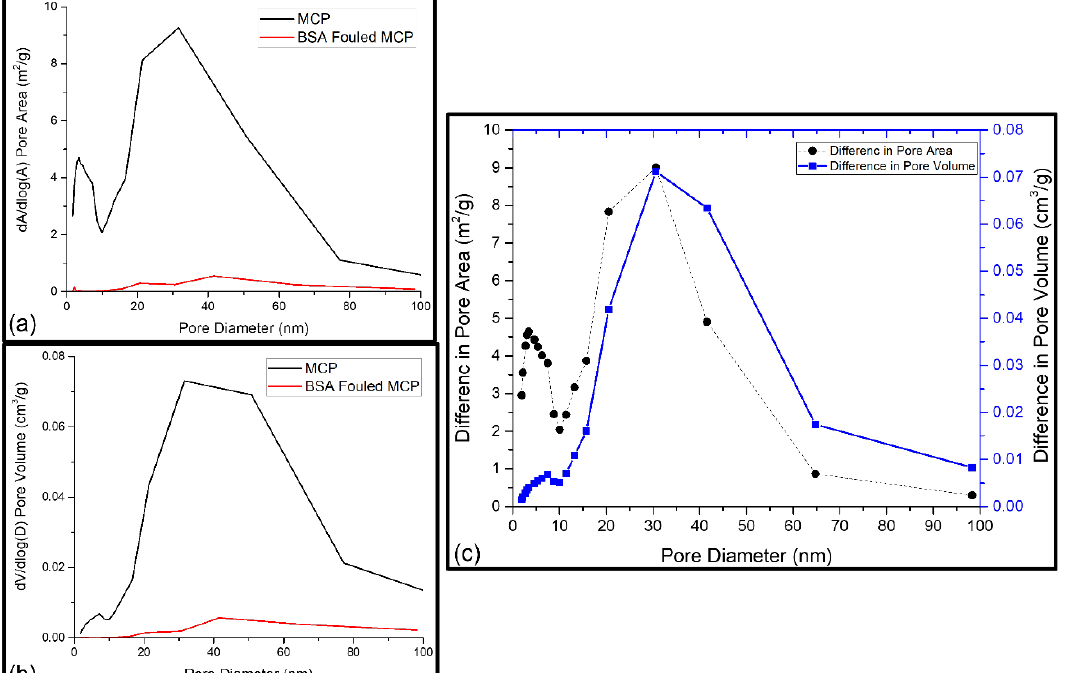
Figure 6. ( a ) BET pore area distribution of CP and BSA-fouled CP membranes; ( b ) BET pore volume distribution of CP and BSA-fouled CP membranes; ( c ) the difference between the pore area of CP and BSA-fouled CP and the difference between the pore volume of CP and BSA-fouled CP as a function of pore diameter.